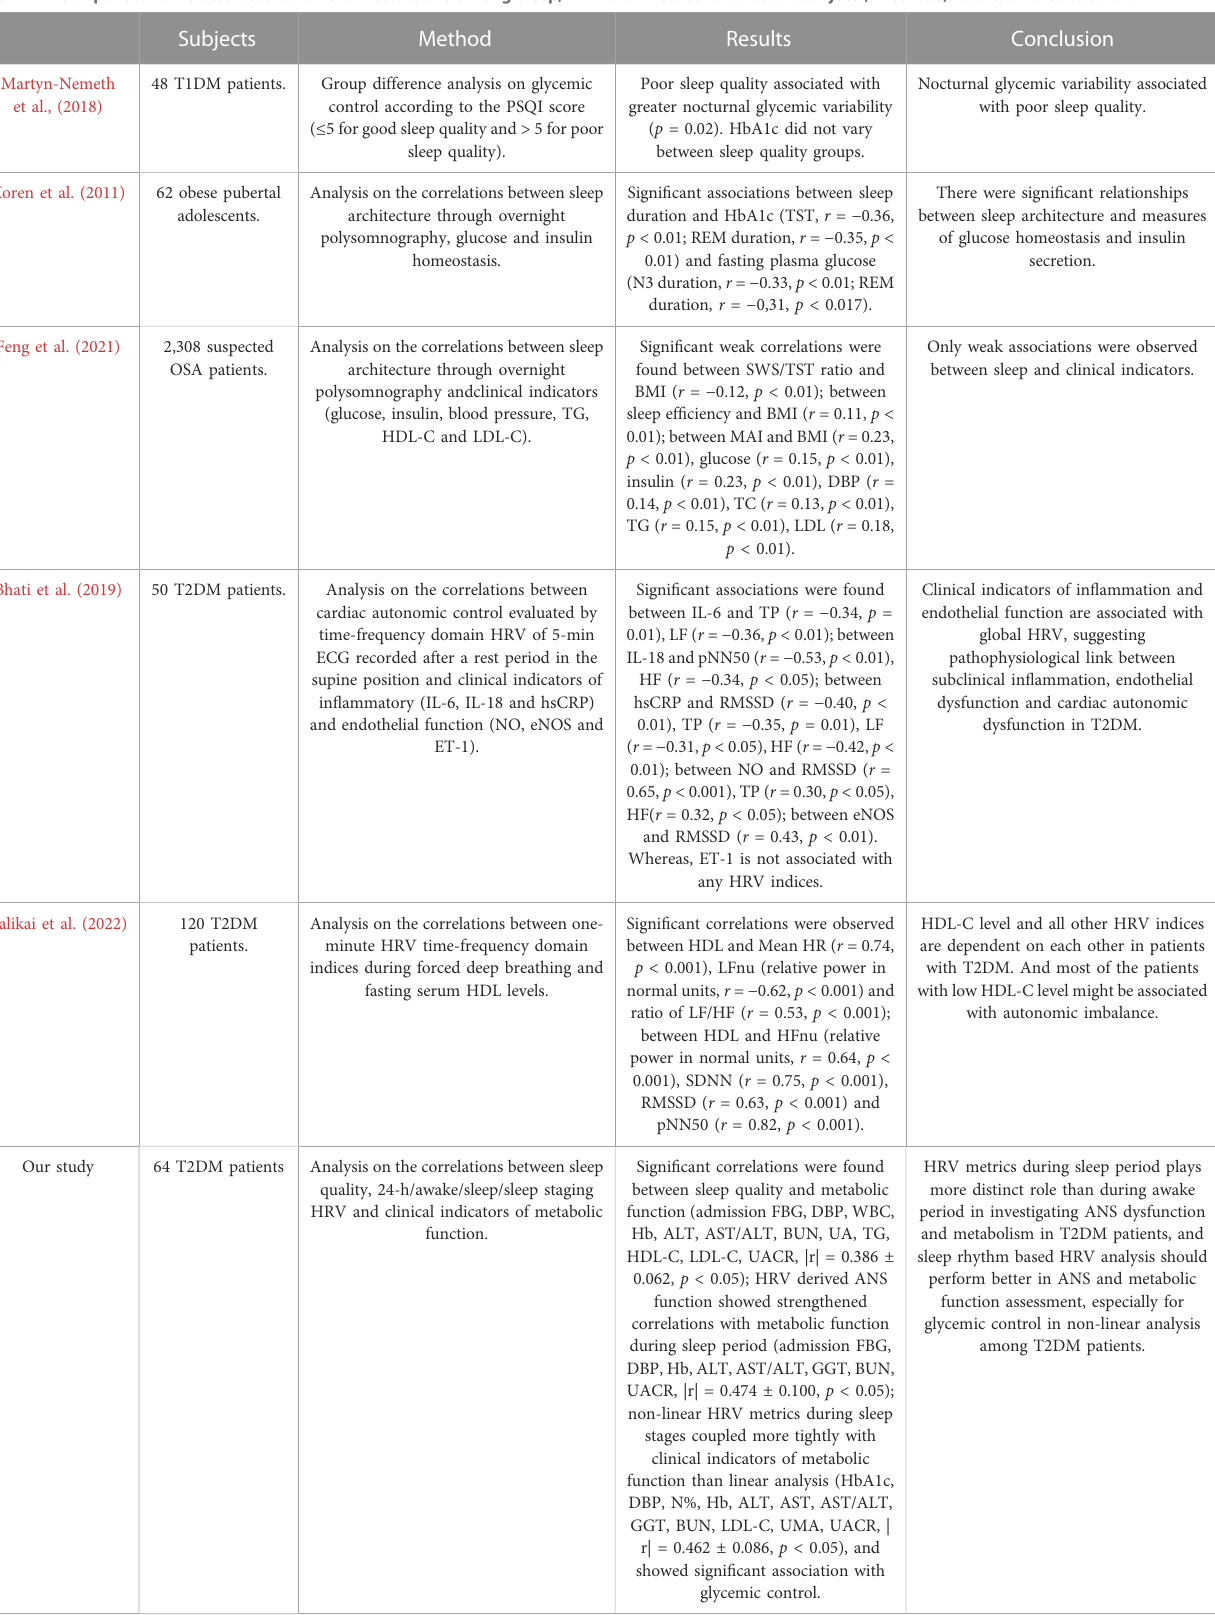
TABLE 11 Comparison of related studies on the interactions among sleep, HRV and metabolic function: subjects, methods, results and